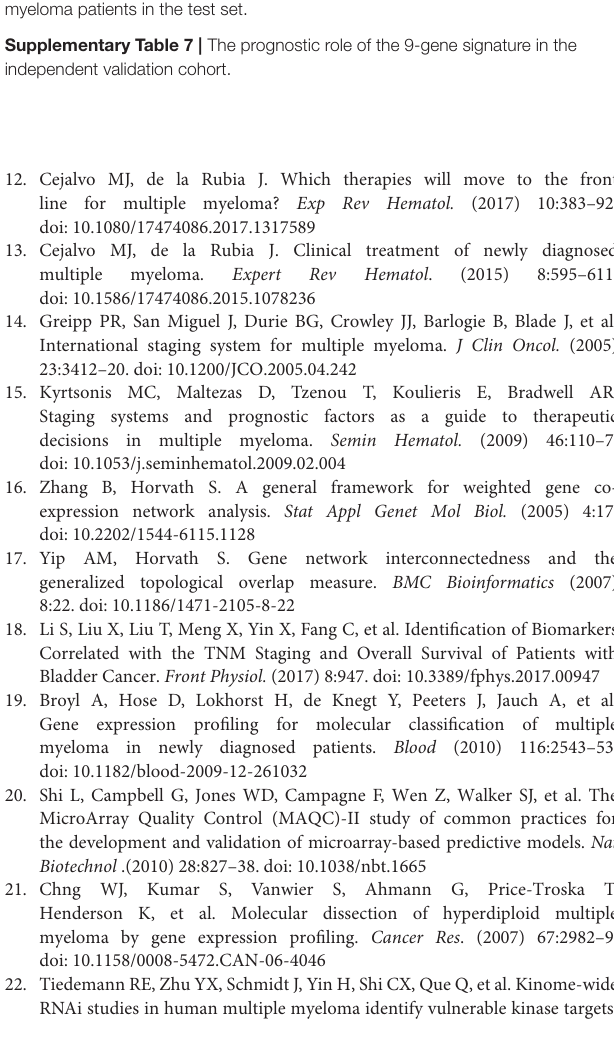
Supplementary Table 3 | Cox proportional hazards regression analysis the association between the clinical characteristics and overall survival of multiple myeloma in the training set. Supplementary Table 4 | Cox proportional hazards regression analysis on the association between the clinical characteristics and overall survival of multiple myeloma patients in the test. set. Supplementary Table 5 | Cox proportional hazards regression analysis on the association between the clinical characteristics and event-free survival of multiple myeloma patients in the training set. Supplementary Table 6 | Cox proportional hazards regression analysis on the association between the clinical characteristics and event-free survival of multiple myeloma patients in the test